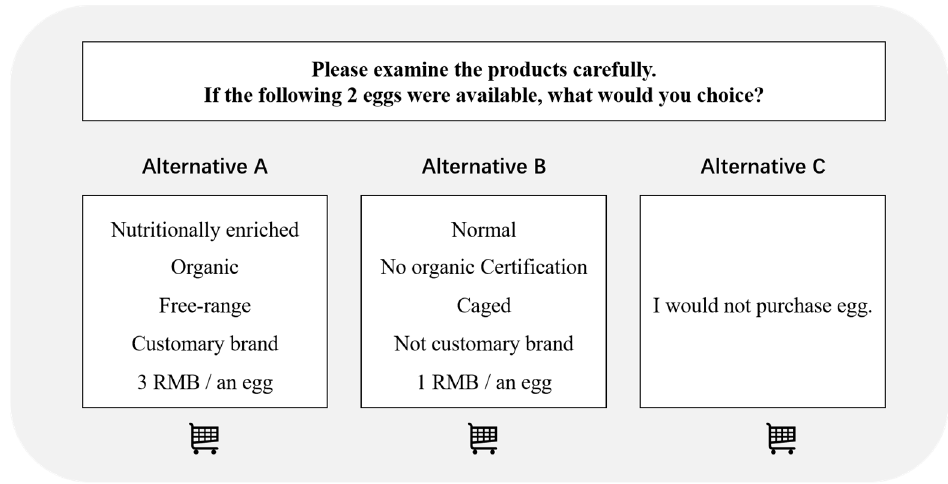
Figure 1. Example of a choice set in the survey.